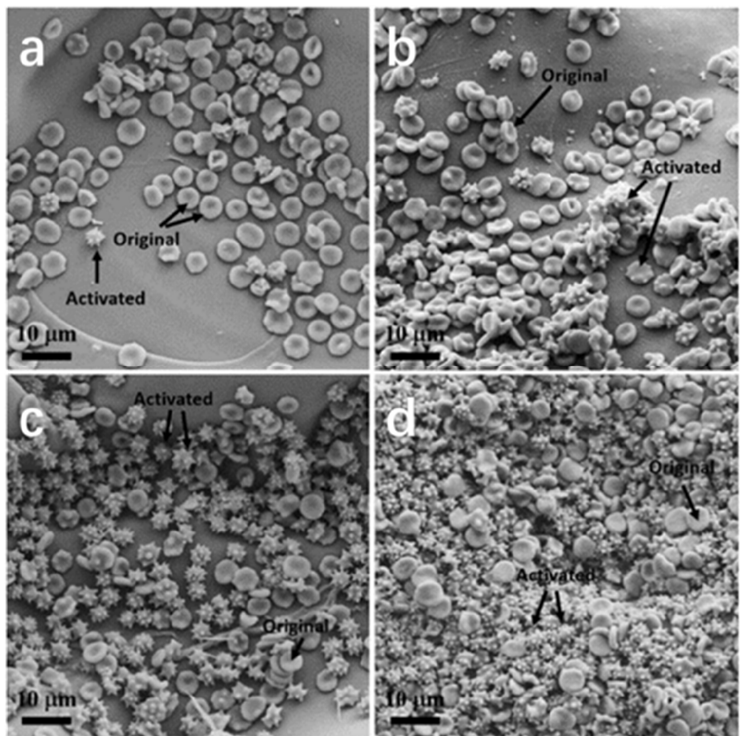
Figure 2. SEM images of erythrocyte adhesion on ( a ) chitosan, ( b ) chitosan (6C), ( c ) chitosan (12C), and ( d ) chitosan (18C) [30].